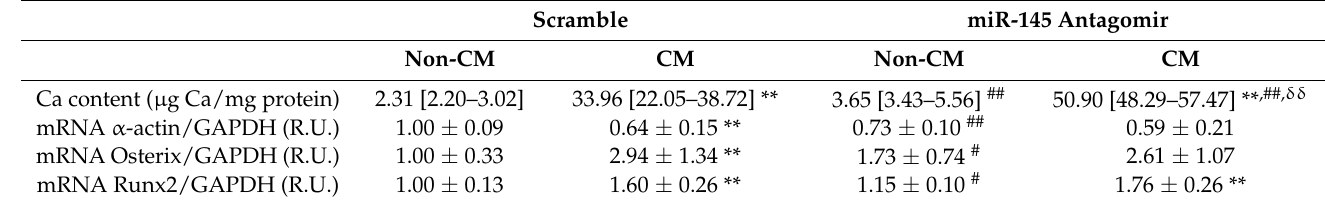
Table 2. Reductions of miR-145 in VSMC contribute to osteogenic differentiation and Ca deposition. Ca deposition, α –actin, osterix and Runx2 gene expression in A7r5 cells transfected with scramble or miR-145 antagomir and exposed to either non calcifying media (non-CM; 1 mM Ca, 1 mM P) or calcifying media (CM; 2 mM Ca, 3 mM P) for 4 days. Values indicate Mean ± SD or Median (interquartile range) from three independent experiments performed in triplicate per experimental condition; R.U.: relative units; ** p < 0.01 vs. non-CM within a transfection group; # p < 0.05 and